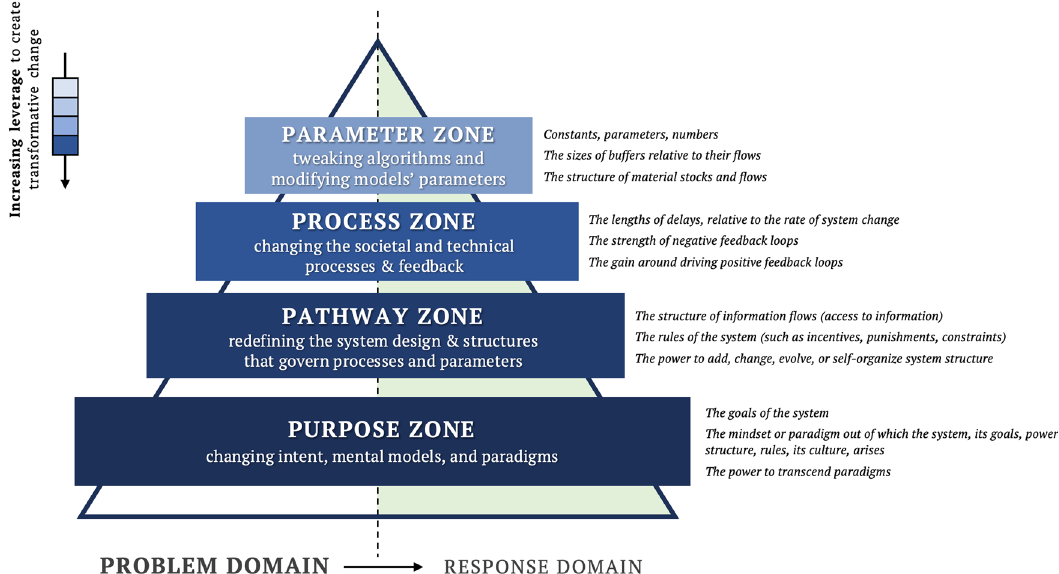
Fig. 1 The 5Ps framework. The diagram illustrates the ‘ leverage zones ’ where interventions can be most effective. The lower zones in the pyramid offer greater leverage than the top zones. The leverage points corresponding to each leverage zone are displayed on the right side. According to Meadows (1999), these points indicate where interventions can be made in a